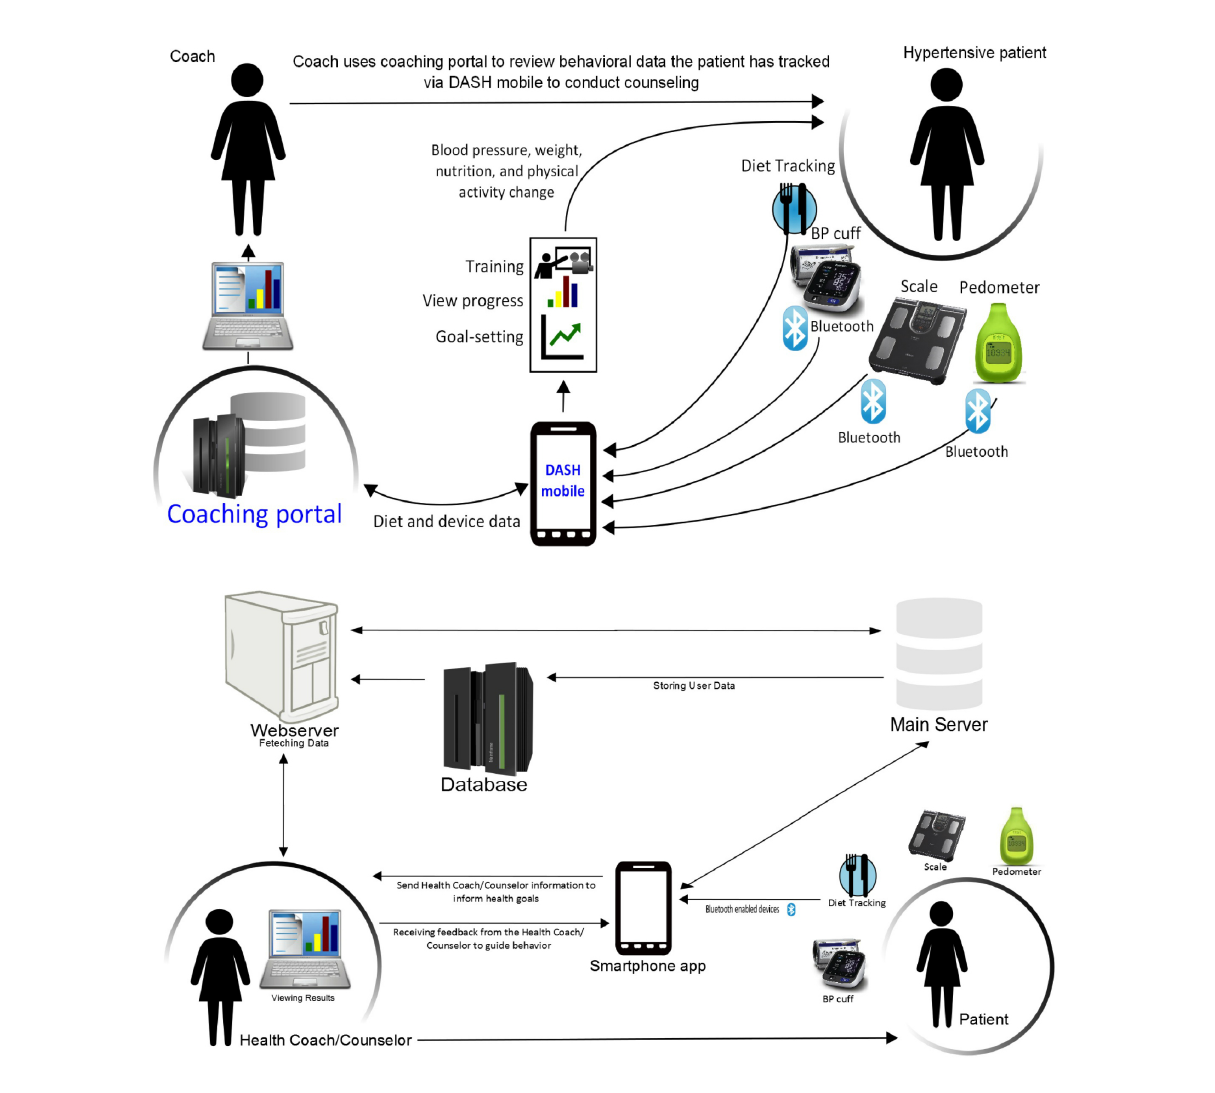
Figure 3. Schematic model of linkages between users, data, and devices of the DASH mobile